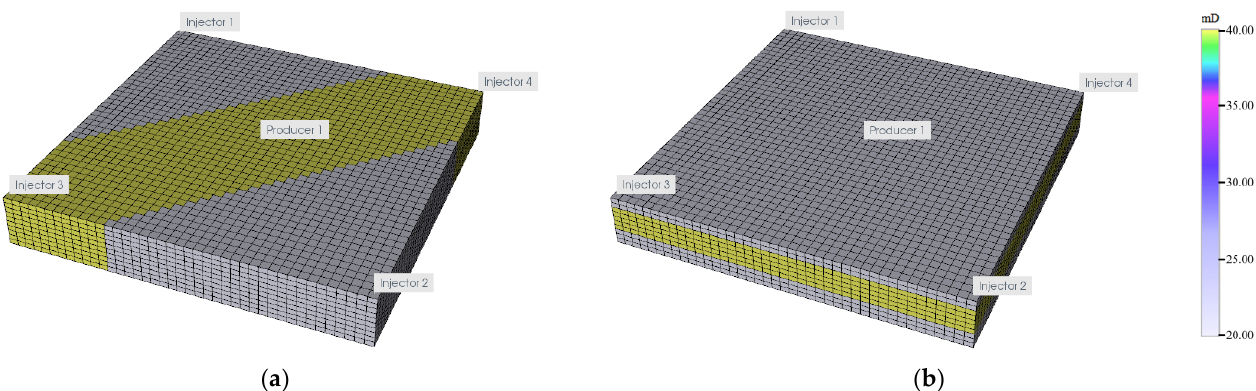
Figure 6. Oil recovery under different formation pressures.